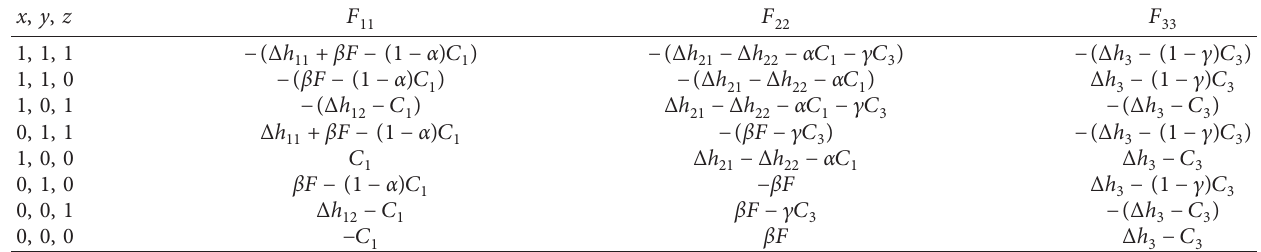
Table 3: Main eigenvalues of the Jacobian matrix.